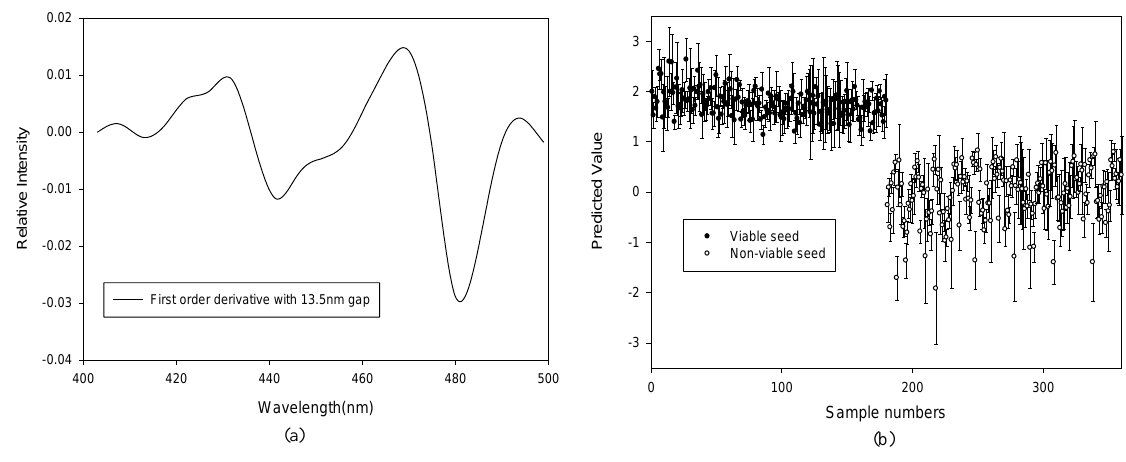
Figure 4. ( a ) Regression coefficients plot of the PLS-DA model, and ( b ) the PLS-DA prediction results obtained using the first-order derivative with a gap of 13.5 nm to discriminate between viable and nonviable pepper seeds based on the reflectance spectra produced under BL (400–500 nm).